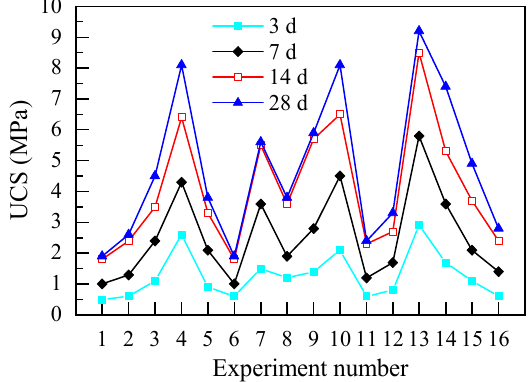
Figure 4. Variation in UCS of the orthogonal experiment.